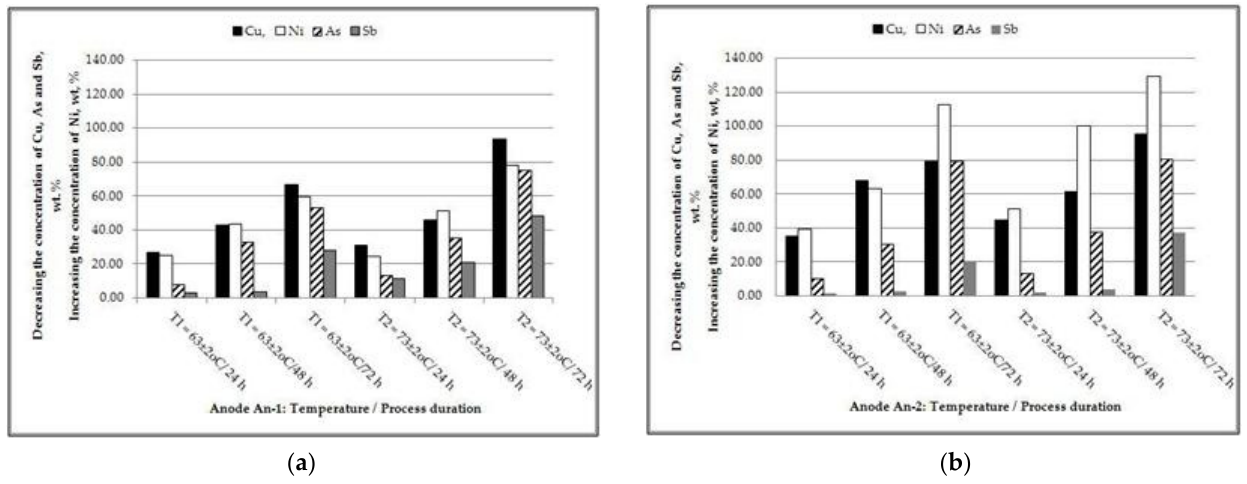
Figure 3. Cu, Ni, As, and Sb concentration changing during the electrorefining process for anodes: ( a ) with sample code An-1 and ( b ) with sample code An-2.